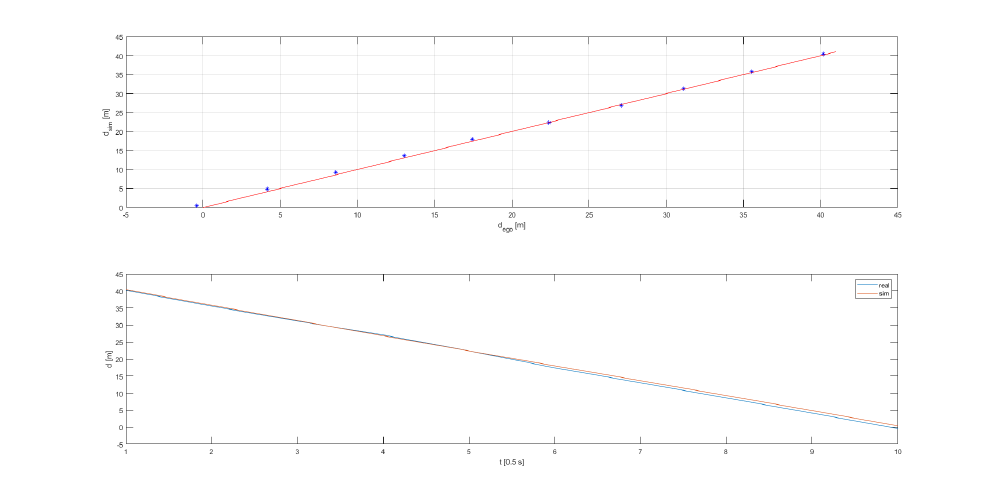
Figure A8. Validation of the real and estimated distance between ego target vehicle in scenario 3.